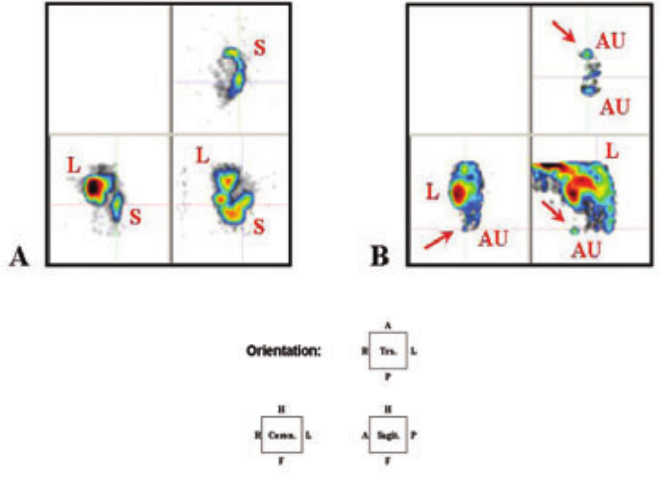
FIGURE 4 - Sections made from the removed intact spleen ( A ) and the regenerated spleen autotransplants ( B ) at the end of the 12-month follow- up